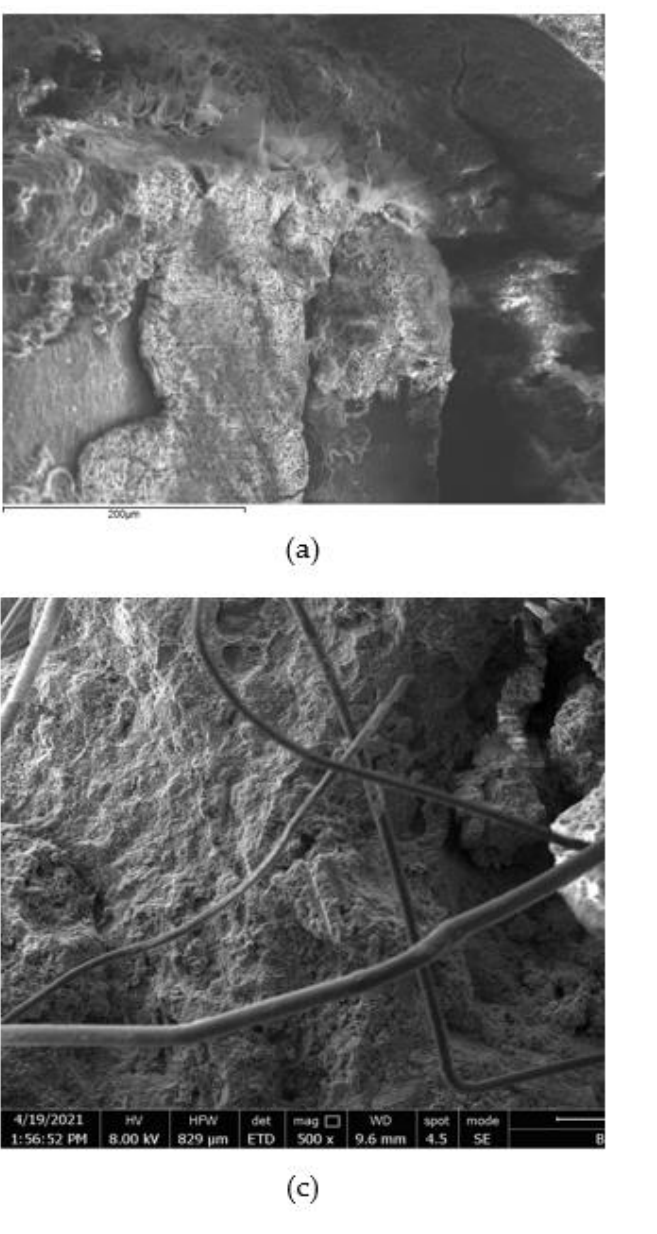
Figure 5. Scanning Electron Microscopy (SEM). ( a , b ) Sample RA-Con-1:3, ( c , d ) Sample RA-Con-1:3-FPP.